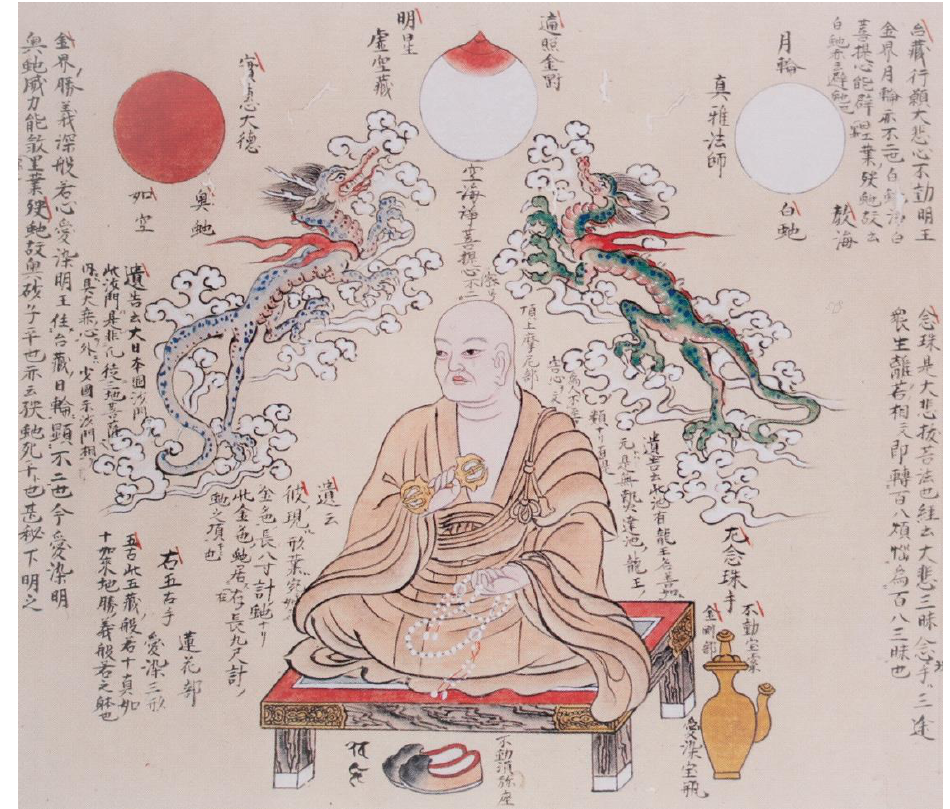
Figure 10. Kūk ai with Jewels and Dragons , 14th century, color on paper. Ninnaji, Kyoto. Reproduced with permission from Faure (2016). Copyright 2016 University of Hawai‘i Press.